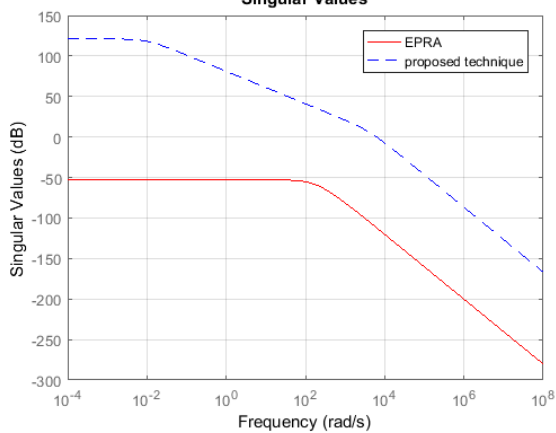
Figure 6. Sigma plot of 𝐾 𝑟 (𝑠)𝑃(𝑠).